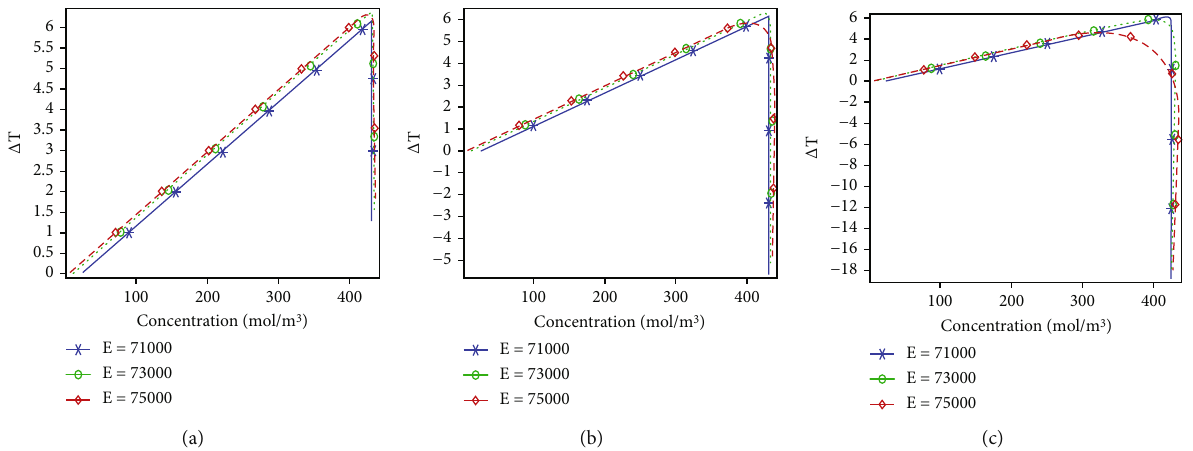
Figure 6: Change in the temperature at upstream along the backward step channel against the concentration of calcium hydroxide at (a) Re = 100 , I : C = 1 % , a = 0 : 5 ; (b) Re = 100 , I : C = 1 % , a = 0 : 6 ; and (c) Re = 100 , I : C = 1 % , a = 0 : 7 .